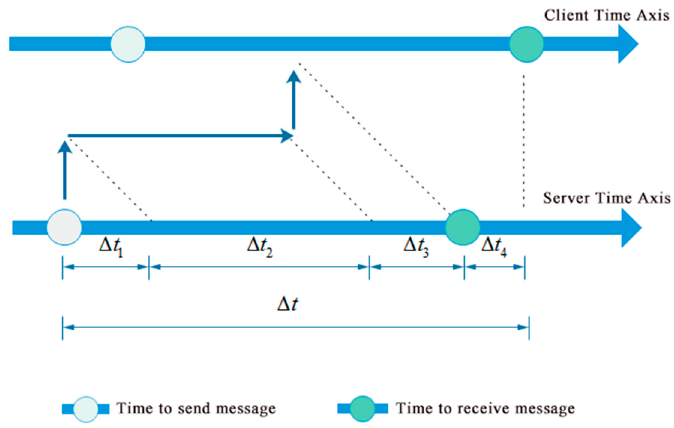
Figure 6. Time analysis of a message transfer from server to client.